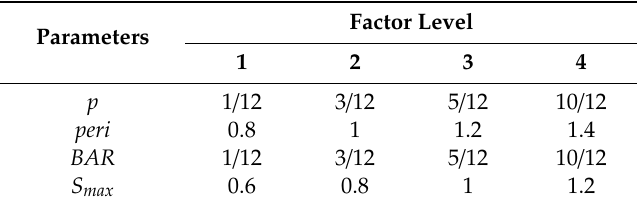
Table 1. Combinations of di ff erent parameter values.